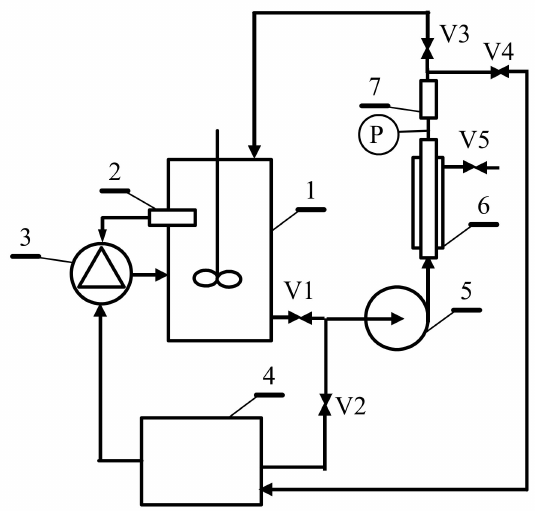
Figure 11. The technological conception of membrane bioreactor with cleaning system with NaOH so- lution. 1—bioreactor, 2—pH sensor, 3—NaOH dosing unit, 4—NaOH tank, 5—pump, 6—membrane module, 7—pH sensor, V1–V5—valves,